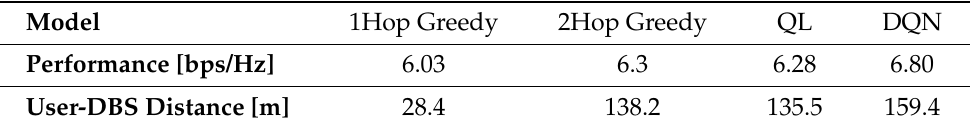
Table 3. Comparing the models for a Macro Base Station (MBS) located at [1000 m, 1000 m].